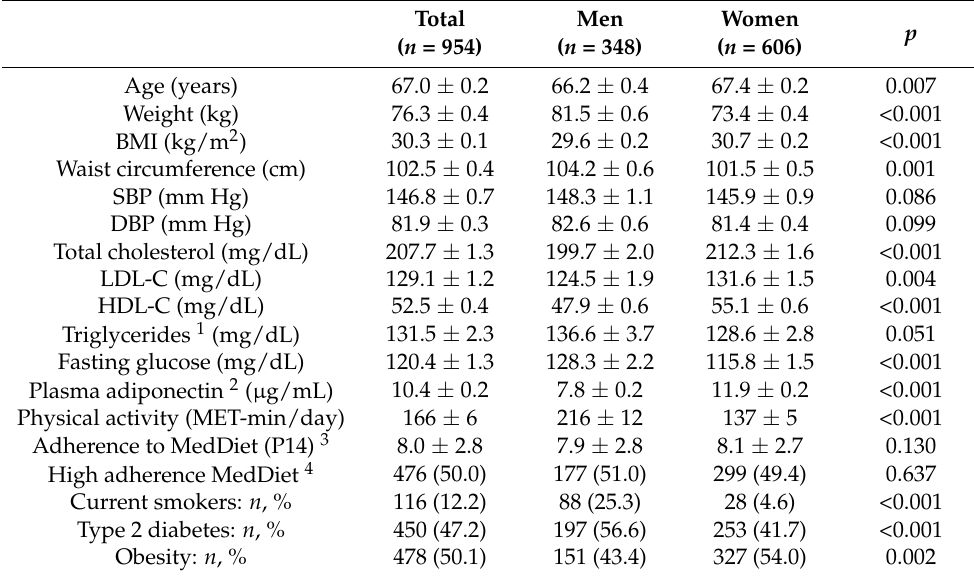
Table 1. Demographic, clinical biochemical and lifestyle characteristics of the study